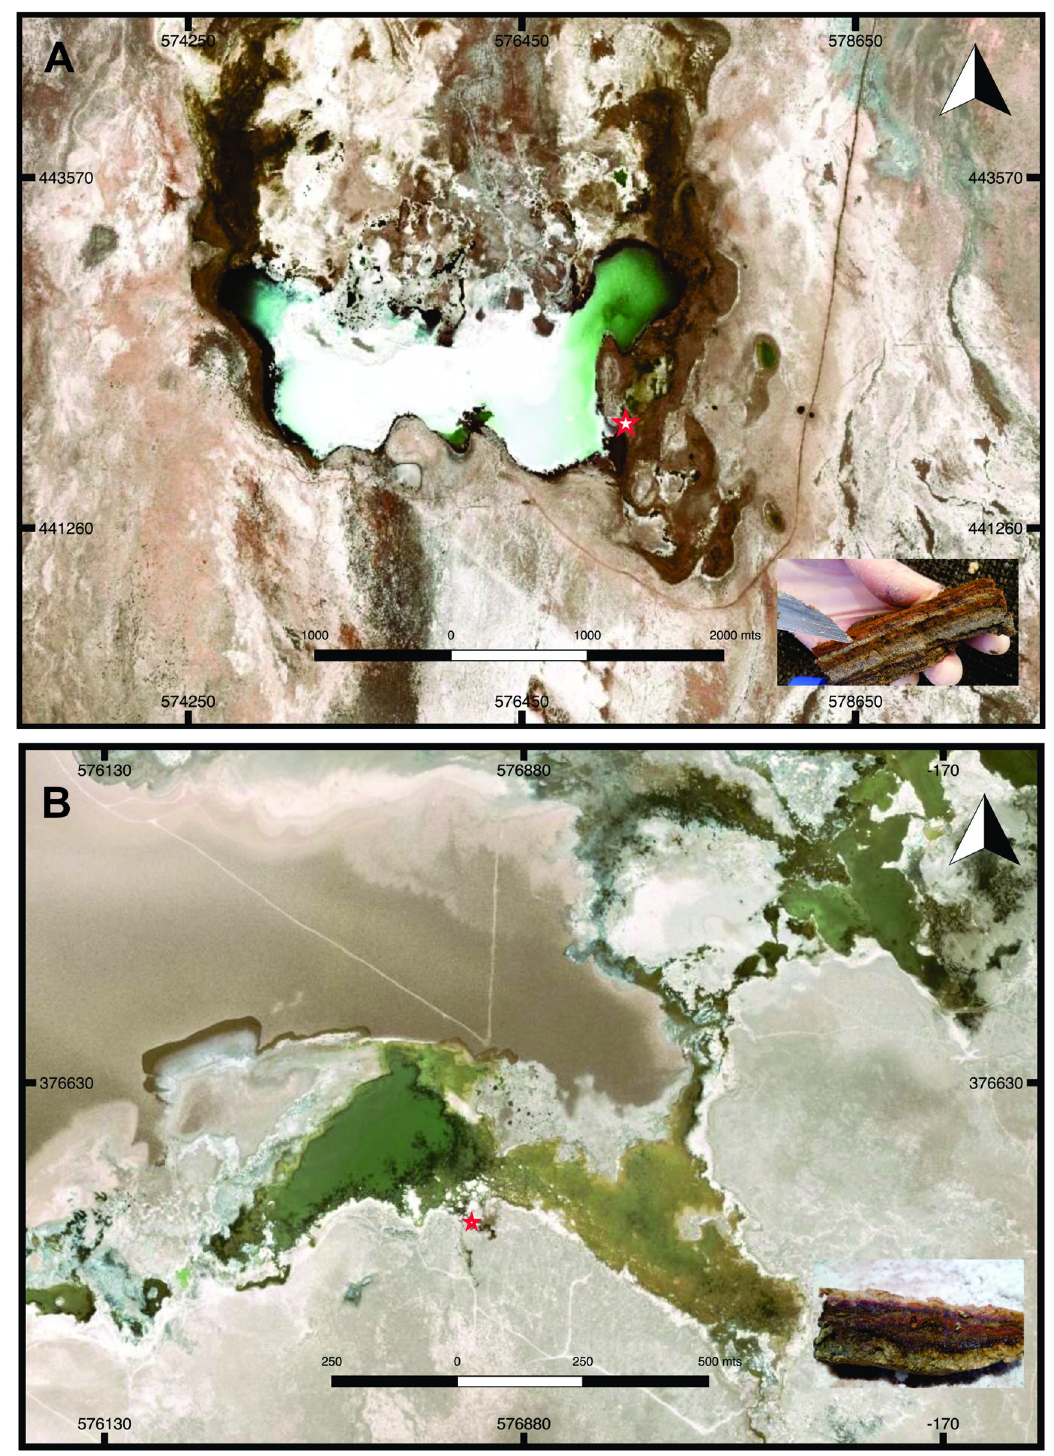
Fig 1. Maps of (A) Tebenquiche and (B) Brava Lakes, showing sample collection sites. Inset: Vertical section of the microbial mats. Map data available from the U.S. Geological Survey.